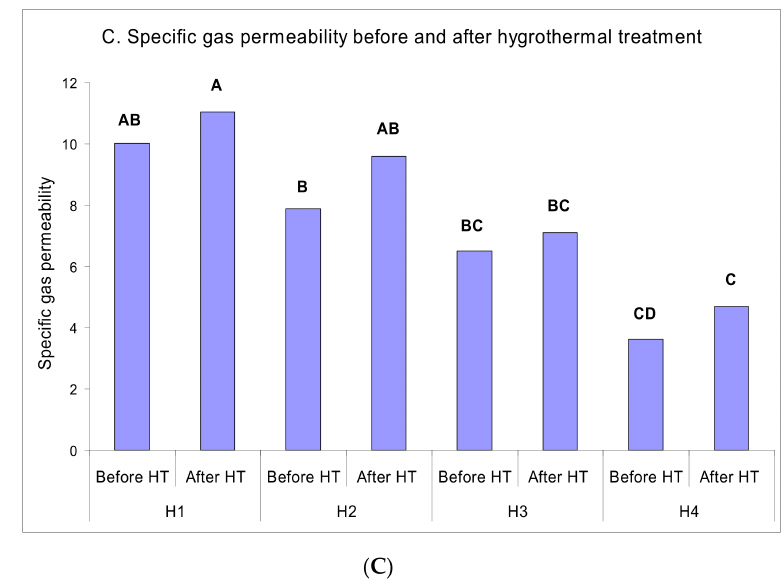
Figure 2. Specific gas permeability values in the un-impregnated specimens heat-treated in hot-air ( A ), hydrothermal ( B ), and hygrothermal ( C ) mediums ( × 10 − 13 m 3 .m − 1 ) (Gas 5) (HT = heat-treated; H number = heated at the number of hours) (Letters on each column represents the Duncan groupings).